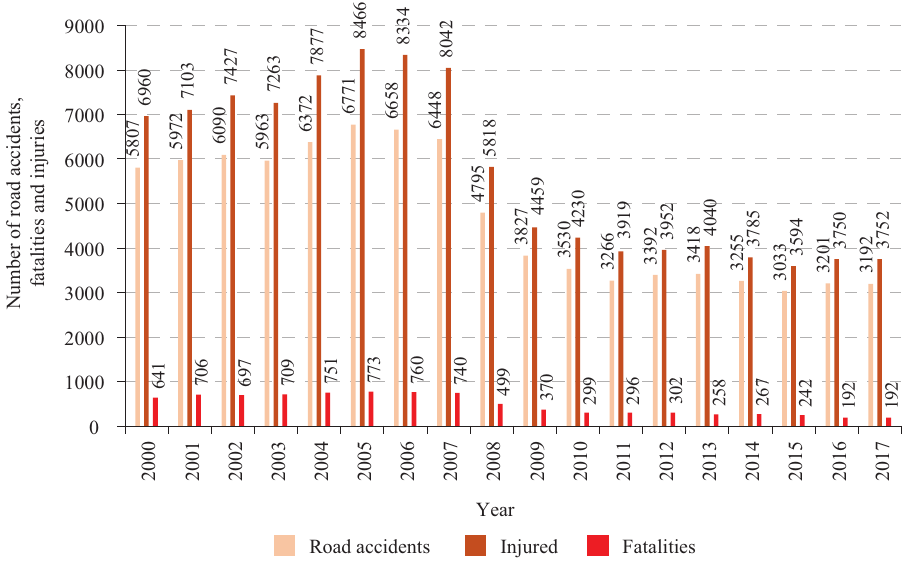
Figure 2. Number of road accidents, fatalities, and injuries from 2000 to 2017 in Lithuania (Lithuanian Road Administration…,